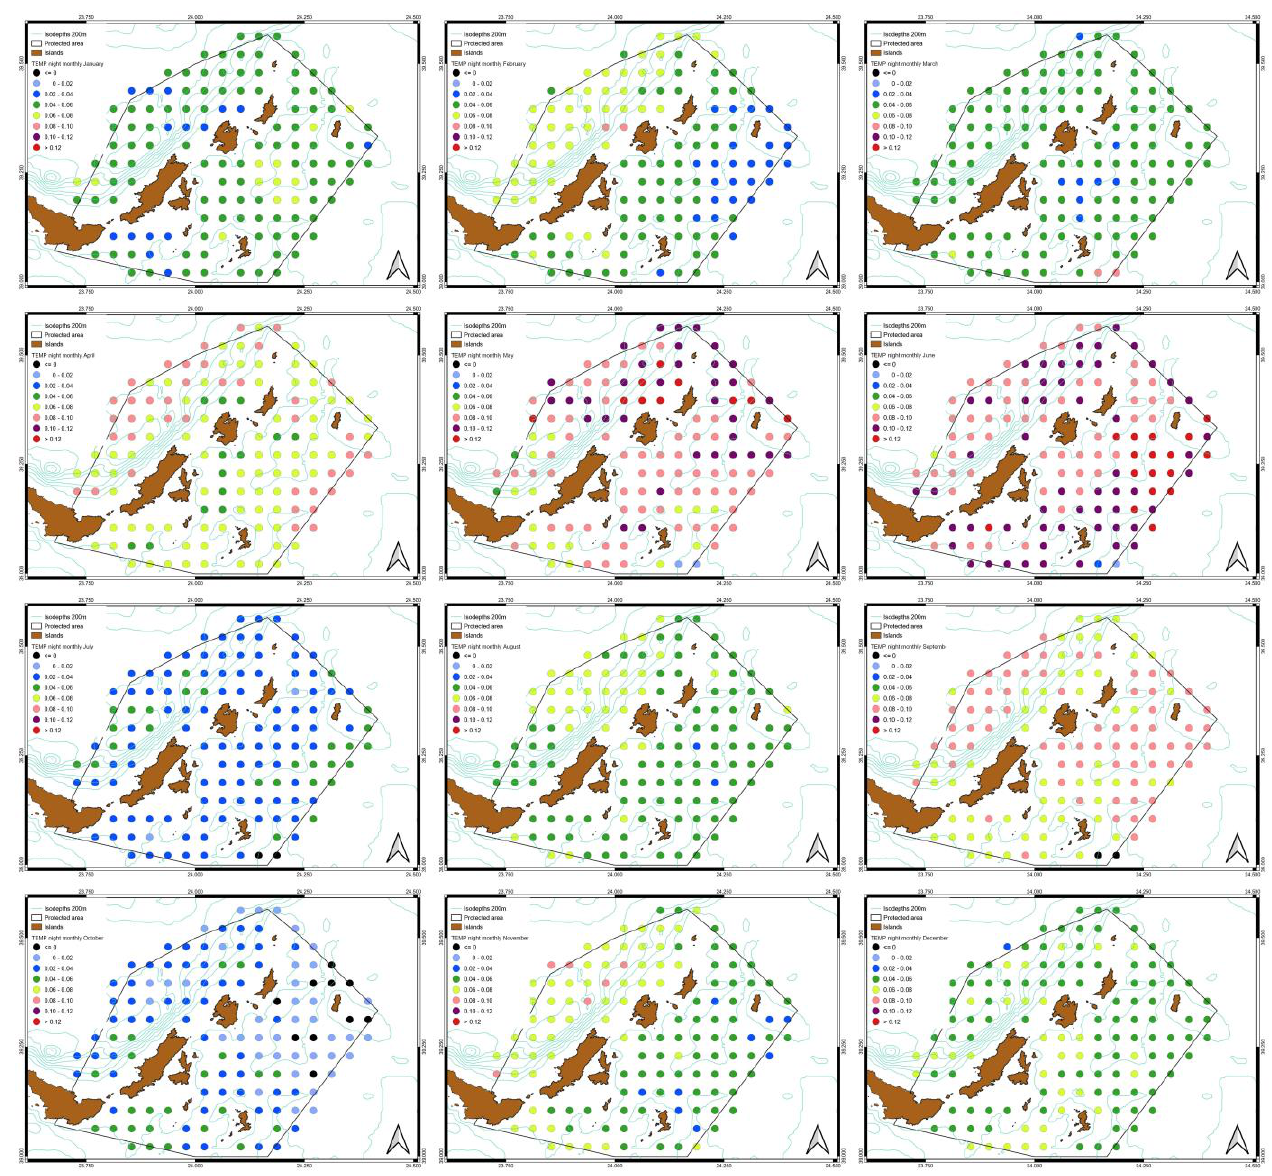
Figure 9. Monthly spatial variation SST night-time slopes. The dark points indicate an increase of temperature which appears just in a few areas. Generally, the SST increases more than the corresponding daytime temperatures.